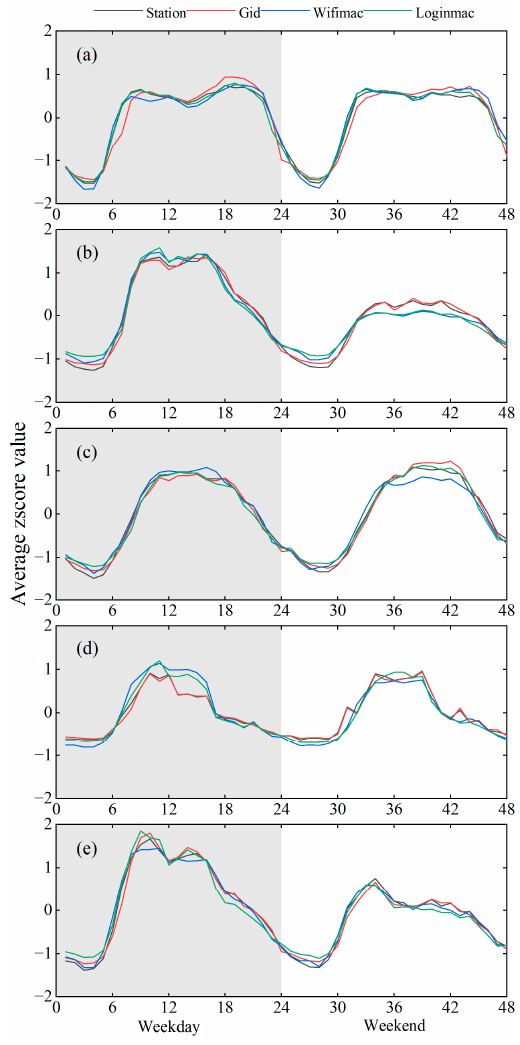
Figure 5. Average value of four MS indicators after normalization for each of the five BFTs: ( a ) Res- idential; ( b ) working; ( c ) entertainment; ( d ) visiting; ( e ) hospital.